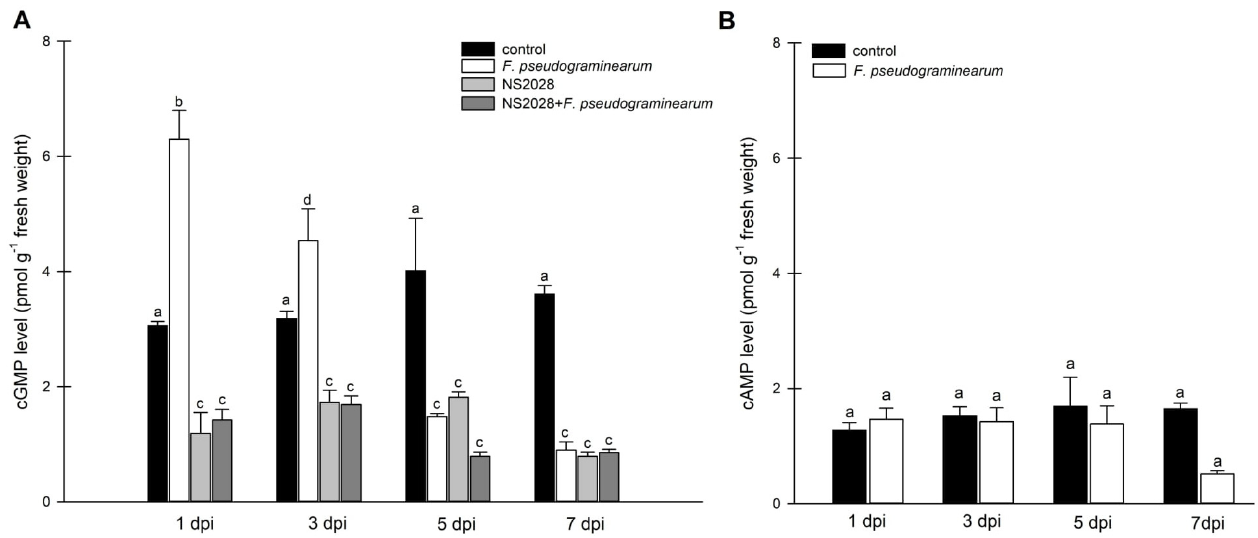
Figure 2. Determination of intracellular cyclic nucleotides levels in B. distachyon plants infected with F. pseudograminearum. ( A ) Time course of cGMP generation in B. distachyon in response to F. pseudograminearum infection and inhibitor (NS 2028) treatment; ( B ) time course of cAMP genera- tion in B. distachyon in response to F. pseudograminearum infection. Control plants were not infected or treated with the inhibitor. The data are shown as mean values ( n = 3), and error bars represent the standard error of the mean. Different letters above the bars indicate significant differences at p < 0.05 (ANOVA followed by Tukey’s test).